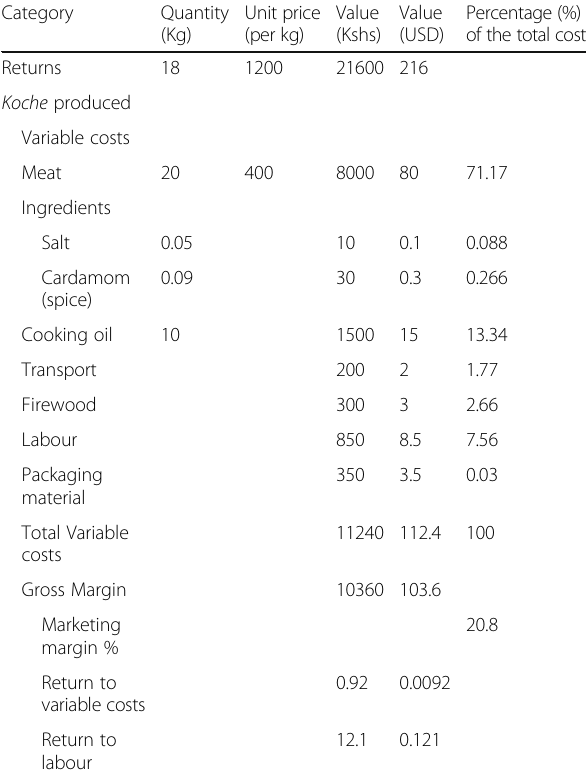
Table 3 Average costs and returns of processing 20kg of camel meat into koche